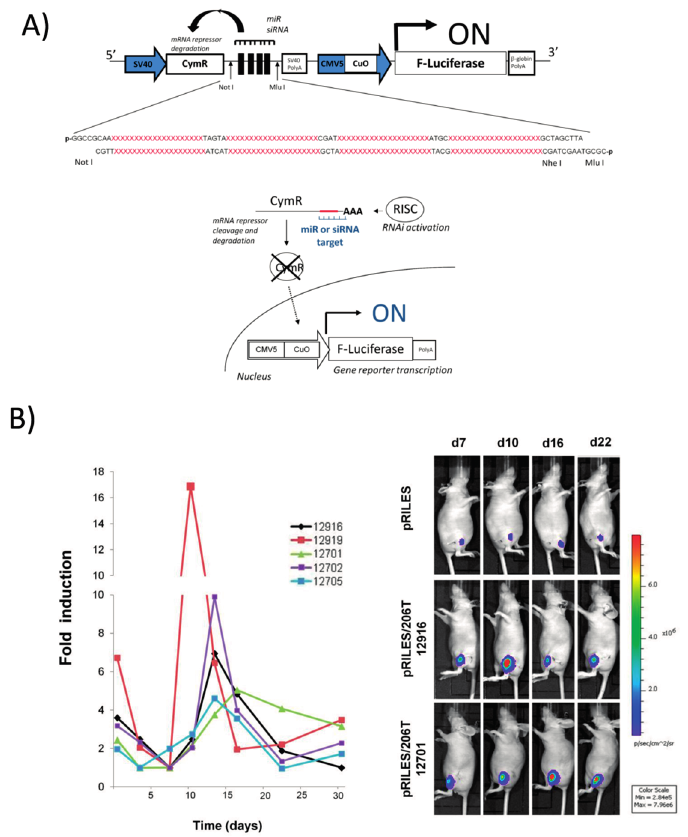
Figure 3. ( A ) Diagram representing the RILES monitoring method. When present in cells, target miRNA binds to the four complementary-block sequences located in the 3'-UTR of the CymR repressor transcript and activates the RNAi silencing complex (RISC) machinery. The CymR mRNA is then cleaved and degraded, resulting in loss of repressor production. The luciferase expression system is thus switched-ON, generating a positive bioluminescence signal; ( B ) Real time monitoring of miRNA-206 regulation during development of skeletal muscle atrophy. Two micrograms of pRILES/206T, designed to detect the expression of miRNA-206, were transfected in the tibialis anterior to transfect the skeletal muscles of nude mice. Three days later the left sciatic nerves were cut surgically to induce denervation and atrophy of the animals’ lower legs. Mice ( n = 5) were thereafter scanned twice a week for the first three weeks and then once a week until day 35 (end point of our experiment). Left Kinetics of miRNA-206 expression detected in each individual mouse through bioluminescence imaging. Results are expressed as relative fold of luciferase induction by normalizing the bioluminescence values to the minimal value found before the bioluminescence peak for each mouse individually. Right Representative bioluminescence images collected from one representative mouse from the pRILES group and two representative mice from the pRILES/206T group at days 7 (d7), 13 (d13), 22 (d22) and 30 (d30). The number identifying each mouse during the longitudinal study is given. Reprinted from